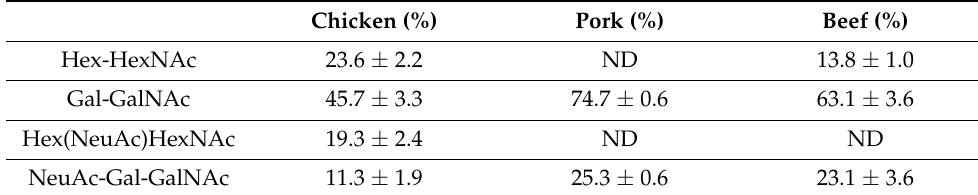
Table 1. Summary of relative abundances of O-glycans in percentage detected in chicken, pork, and beef. ( ± , standard error of mean; ND, not